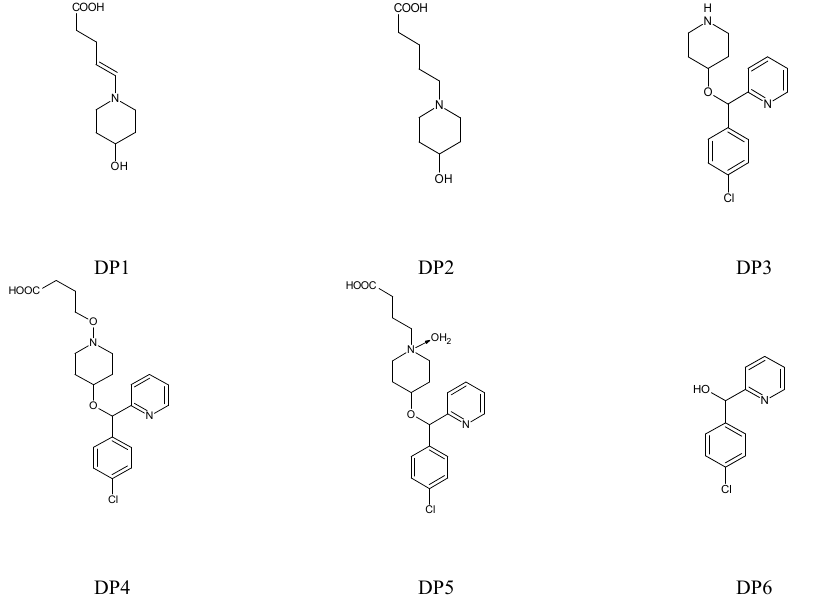
Figure 4. Chemical structures of the degradation products of bepotastine (BEPO) [25,26]. Active pharmaceutical ingredients (APIs) undergo chemical and physical changes when they are affected by external factors such as temperature, humidity, pH and